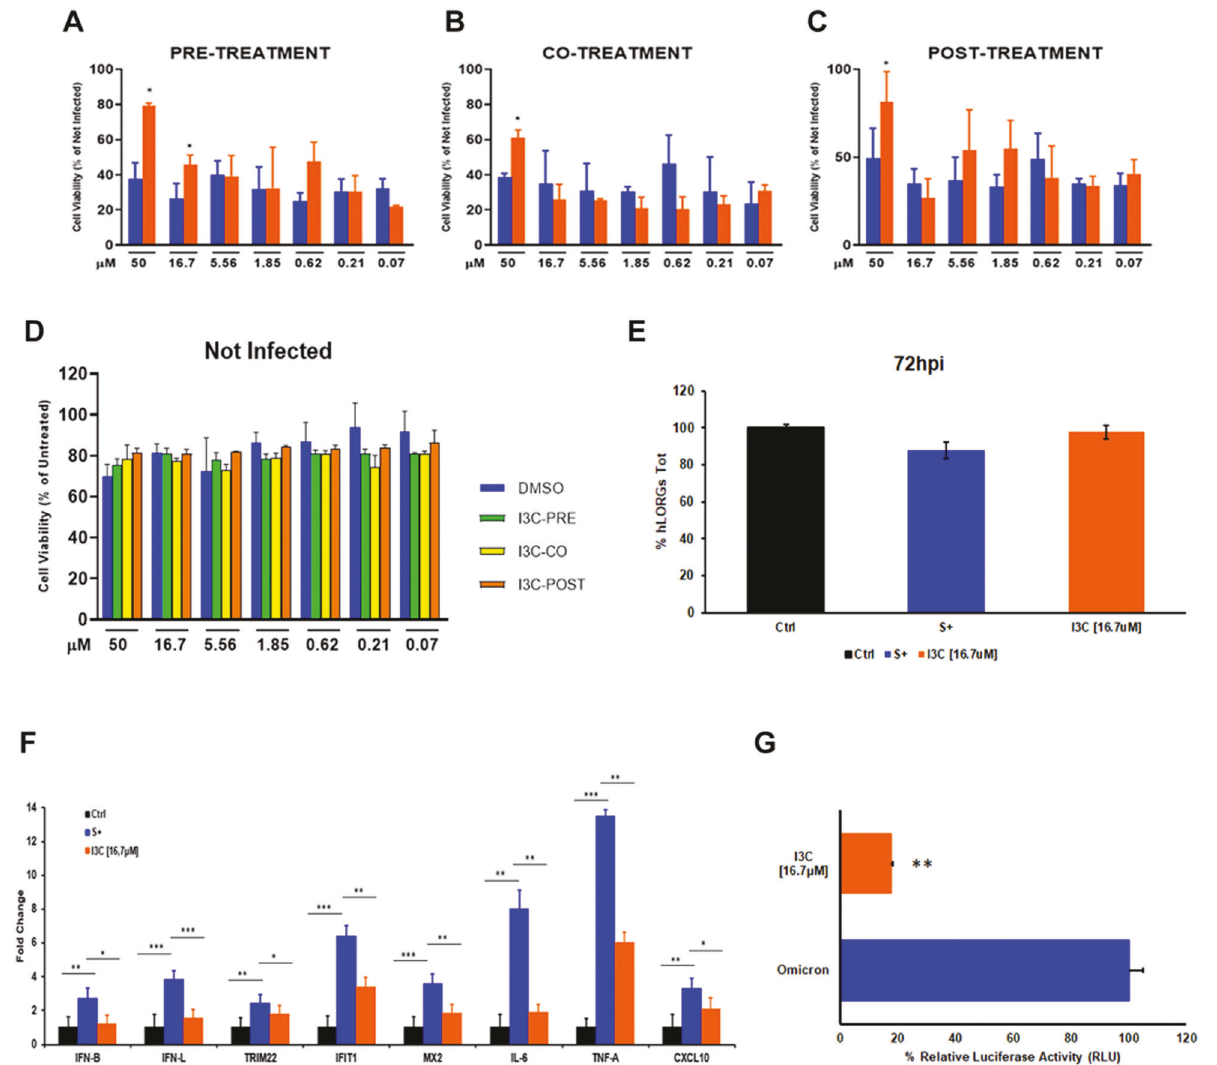
Fig. 2 I3C antiviral activity in vitro . Cells were treated with different doses of I3C (orange bar) or DMSO (blue bar) 1 h before ( A ), together ( B ) and 1 h after ( C ) of SARS-CoV-2 infection (MOI = 0.001). D Cells treated as in ( A – C ) were left uninfected to evaluate cell toxicity. The results were evaluated 72 h post-treatment by setting the uninfected and untreated control cells as 100% and the remaining values represented as a relative value. Data are expressed as mean ± SD ( n = 9) of three independent experiments performed in triplicated. Results were analysed using Graph Pad Software (GraphPad Prism 9). Statistically signi fi cant differences between DMSO and I3C are represented as * p < 0.05 determined using the Wilcoxon test. E Percentage of hLORGs tot reformed after 72 h post infection (hpi) with VSVpp.SARS-2-S D614G variants. n = 25 – 30 fi elds from three biological replicates and two different observers. F Expression of immunity-related genes in hLORGs 72 h post- treatment, with (S + ) and without (Ctrl) spike protein of VSVpp.SARS-2-S and following treatment with I3C at 16.7 µM. Bar graph shows expression of immune response genes and cytokines, quanti fi ed by qRT-PCR at 72 h post-treatment ( n = 6). * p < 0.05, ** p < 0.01 and *** p < 0.001 by one-way ANOVA test. G Transduction ef fi ciency was quanti fi ed by measuring virus-encoded luciferase activity in cell infected after 72 h post I3C treatment with Pseudo type Lentivirus SARS-2-Omicron. Data are expressed as the percentage of infection and the average data ( n = 6) from three biological replicates and reported as mean ± standard error of the mean (SEM). Each biological replicate has been performed in duplicate. ** p < 0.01 by Student ’ s